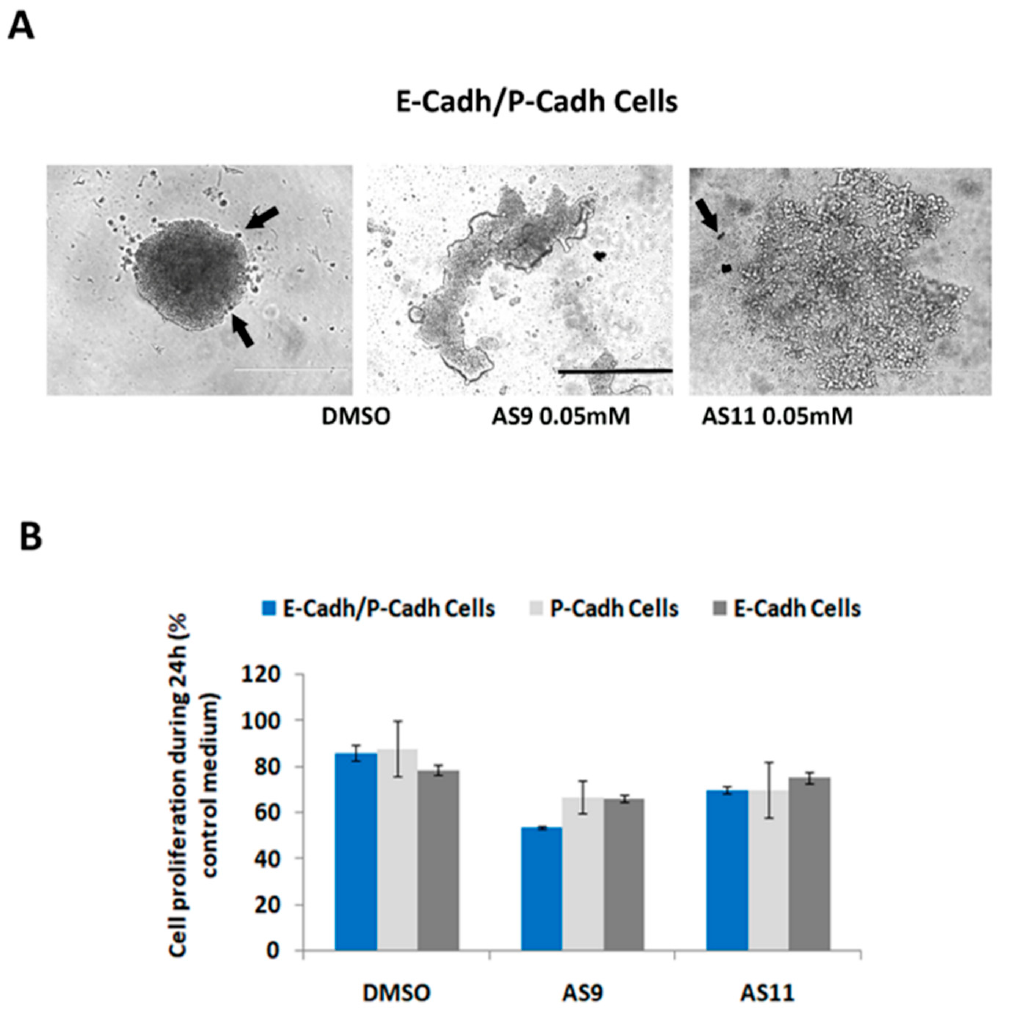
Figure 6. ( A ) BxPC-3 E-cadh / P-cadh cells were treated with 0.1% DMSO or 0.05 mM of inhibitor and allowed to form aggregates for 24 h. Cell viability was then assessed by a trypan blue exclusion test. Black arrows indicate dead cells. Scale bar: 400 μ m ( B ) BxPC-3 E-cadh/P-cadh, BxPC-3 E-cadh, and BxPC-3 P-cadh cells were seeded at a density of 4000 cells per well in 96-well plates. Twenty-four hours after plating, cells were further incubated for another 24 h with 0.1% DMSO or with 0.05 mM of AS9 or AS11. Cell numbers were analysed using thiazolyl blue tetrazolium bromide (Sigma) staining according to the manufacturer’s instructions.